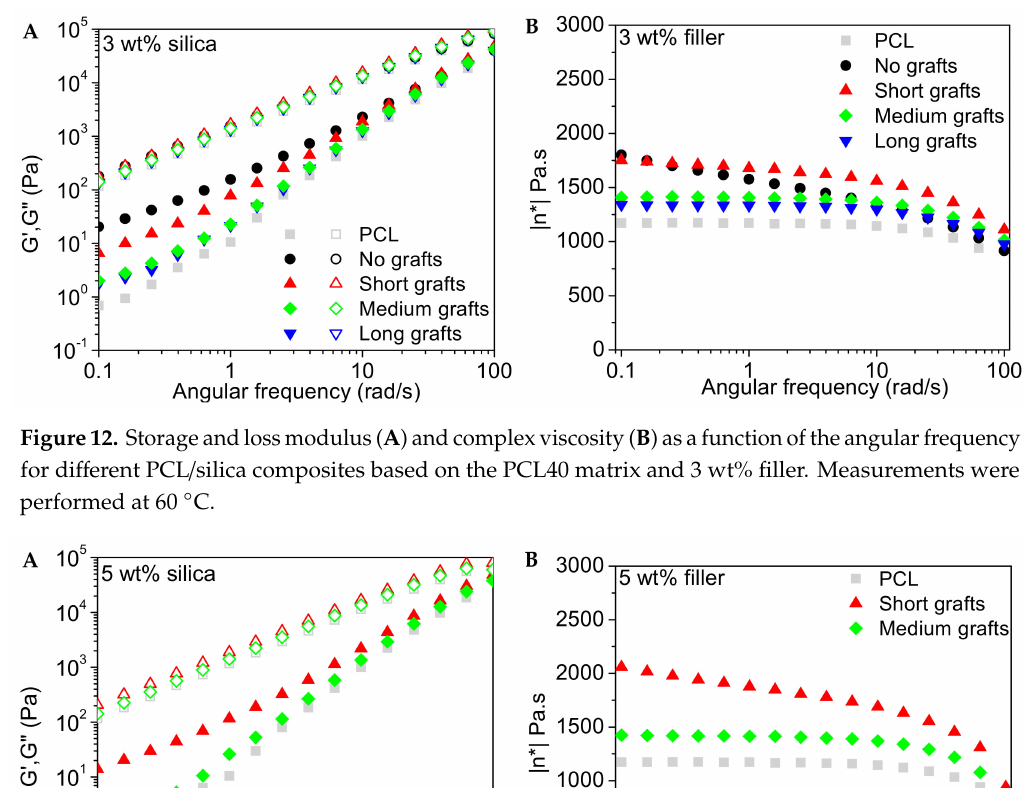
Figure 11. Storage and loss modulus ( A ) and complex viscosity ( B ) as a function of angular frequency for di ff erent PCL / silica composites based on the PCL40 matrix and 1 wt% filler. Measurements were performed at 60 ◦ C.